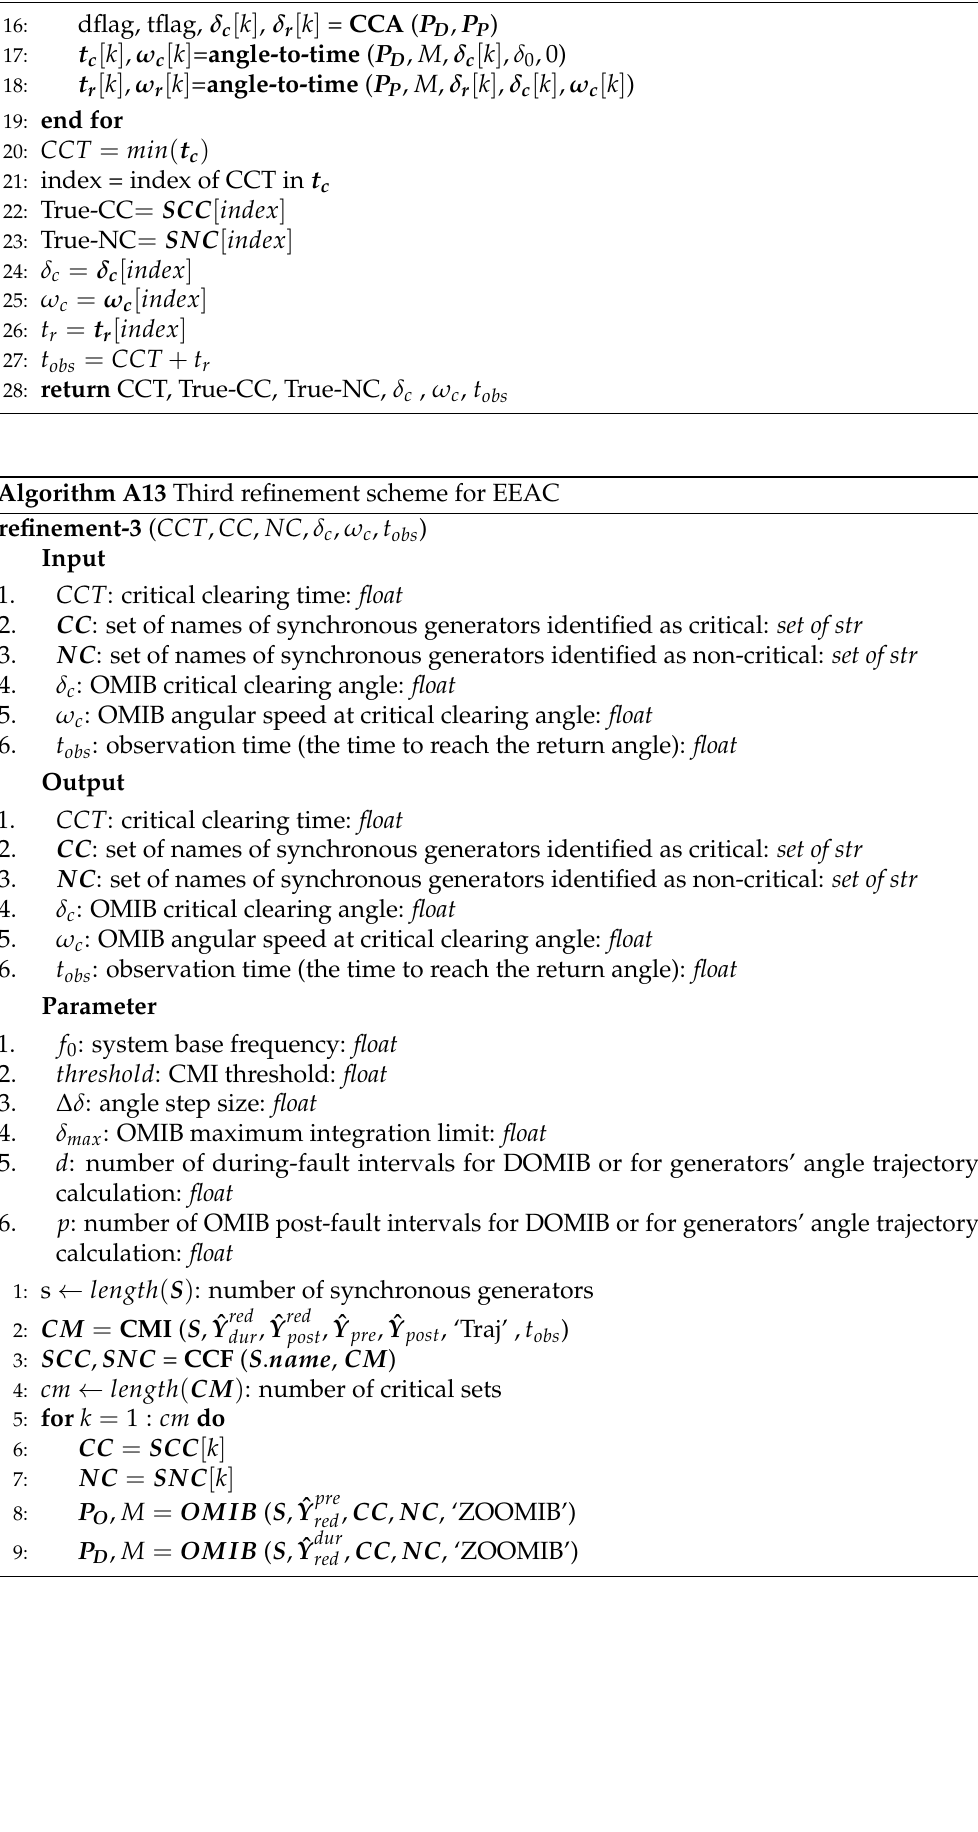
Algorithm A12 Cont.